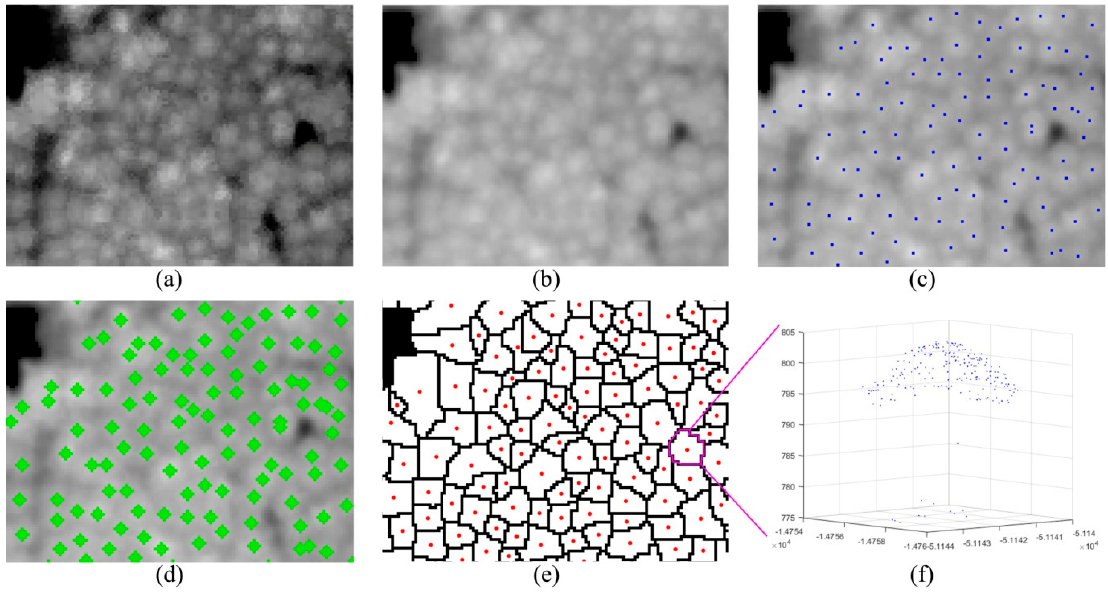
Figure 5. Procedure used for individual tree detection and feature extraction. ( a ) Corrected CHM; ( b ) Gaussian-filtered image; ( c ) potential tree tops; ( d ) dilated tree tops; ( e ) watershed segmented tree crowns with tree tops; and ( f ) laser point clouds within an individual tree crown.